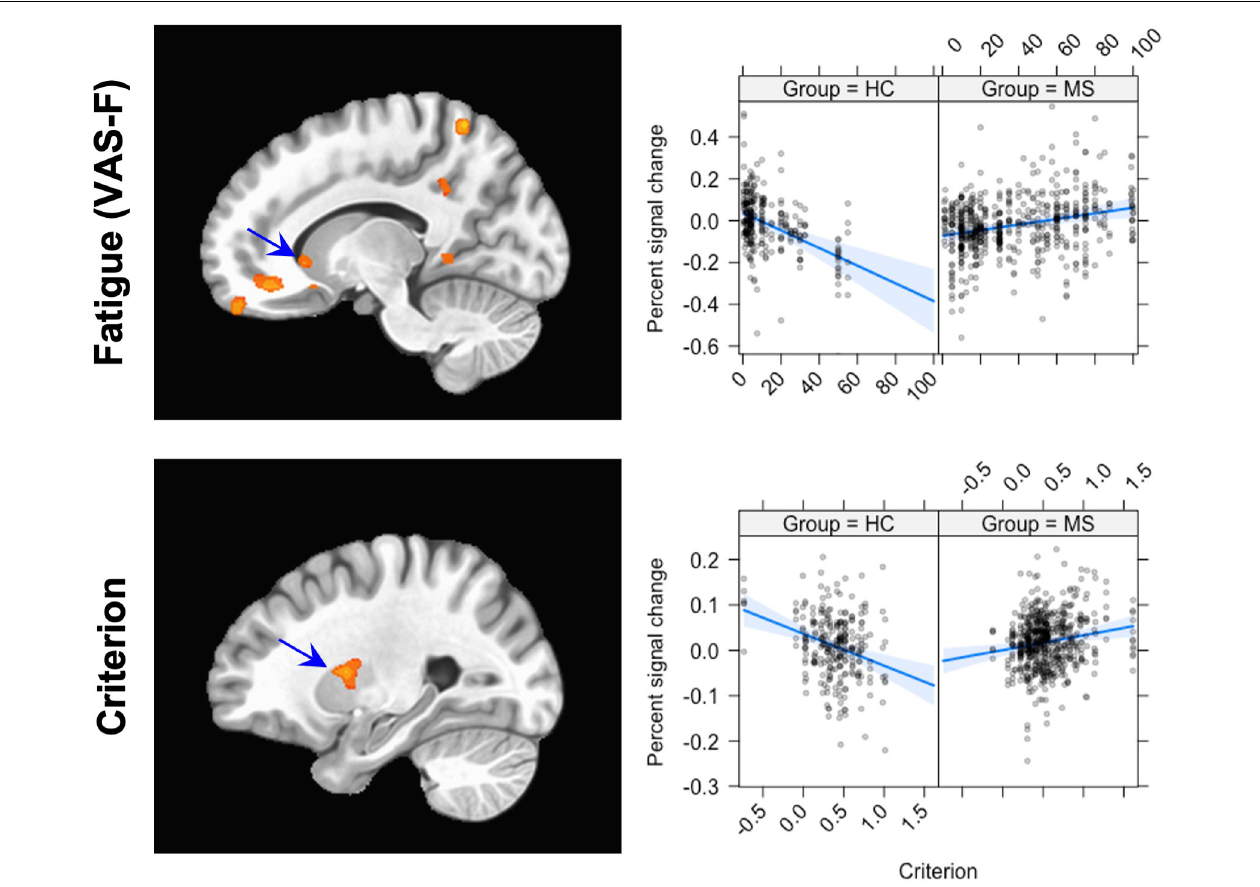
FIGURE 2 | The Group × VAS-F interaction (top row) and the Group x Criterion interaction (bottom row). The panel on the left shows the location of the interaction; the panel on the right shows graphs of the interaction. For the Group × VAS-F interaction, the location plotted is (X, Y, Z = –3, 47, –22); for the Group × Criterion interaction, the location is (X, Y, Z = –27, 2, 10). The scatterplots show the relationship between Percent signal change (ordinate) and VAS-F (abscissa, top) and Criterion (abscissa, bottom). The blue line shows the best fitting linear trend and the blue shaded area shows the 95% confidence